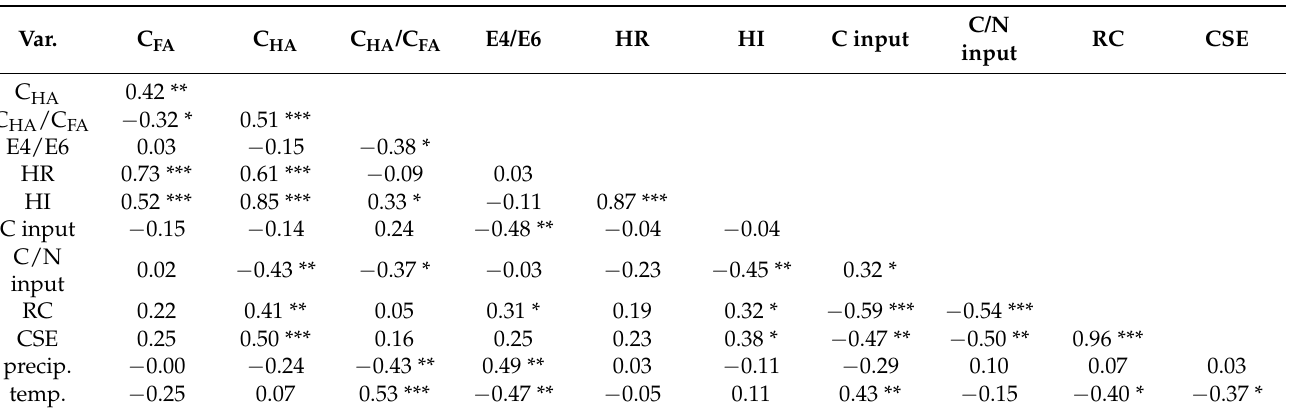
Table 3. Pearson’s correlation coefficients (r) among